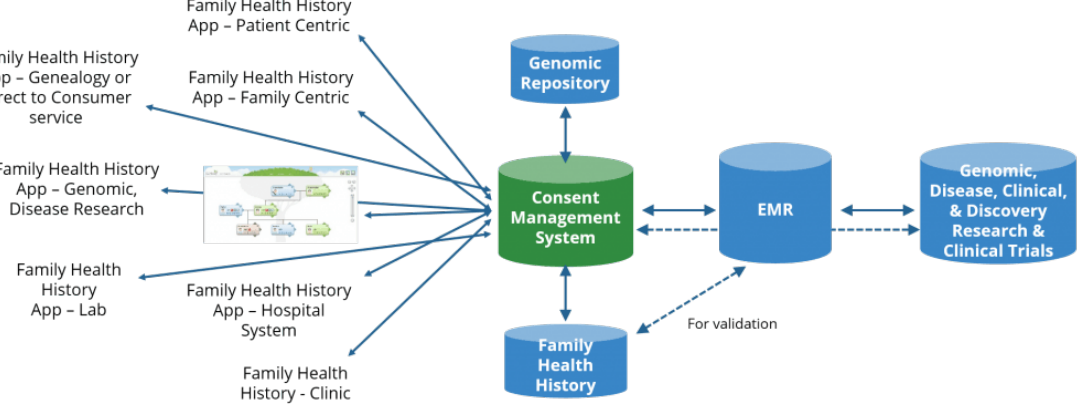
Figure 1. FHH app ecosystem. Image sourced from the Global Genomic Medicine Consortium. EMR: Electronic Medical Record .